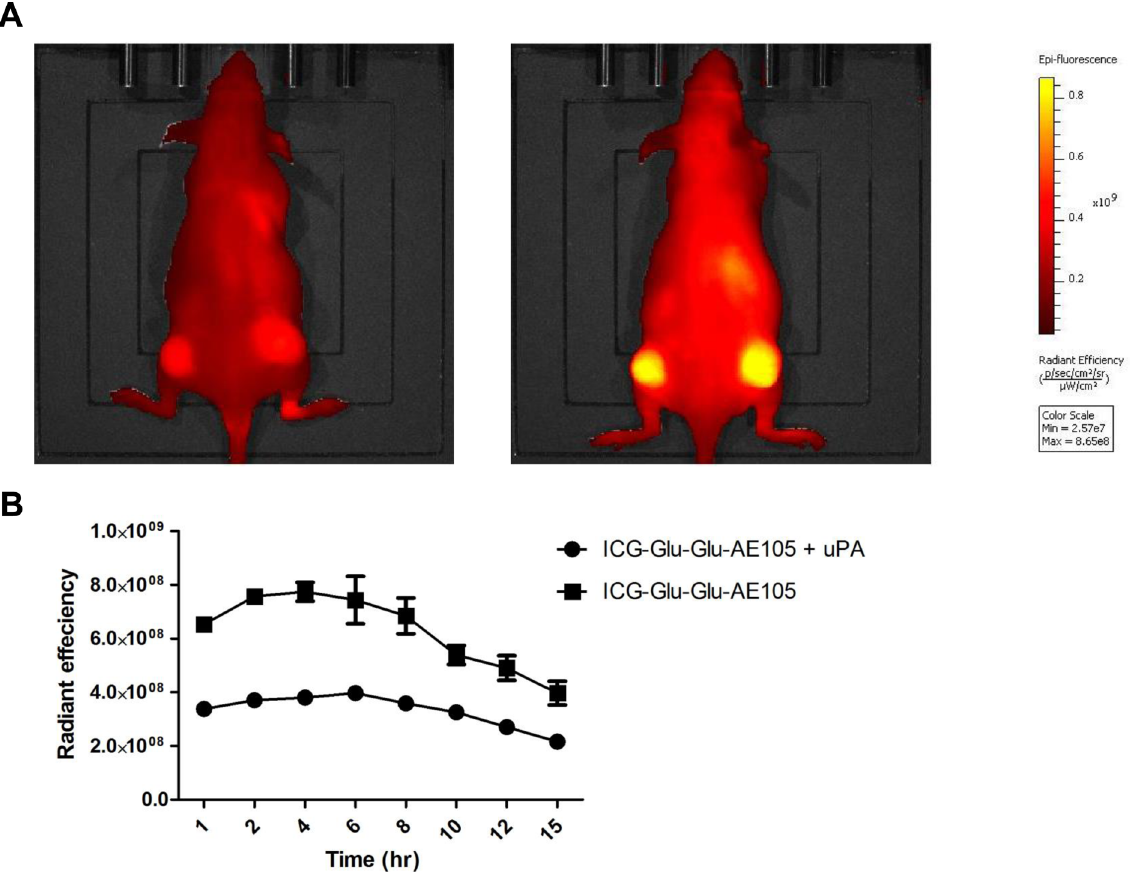
Fig 5. In vivo blocking of ICG-Glu-Glu-AE105 by uPA, the natural ligand. (A) Representative images obtained by the IVIS Lumina XR at 710 nm showing a mouse receiving uPA simultaneously with ICG-Glu-Glu-AE105 resulting in decreased signal compared to a mouse only receiving ICG-Glu-Glu-AE105. (B) Two groups of mice (n = 4) were dynamically scanned with either ICG-Glu-Glu-AE105 + uPA or ICG-Glu-Glu-AE105. In all timepoints the two groups were significantly different with the group receiving only ICG-Glu-Glu-E105 having a 2 fold higher signal.